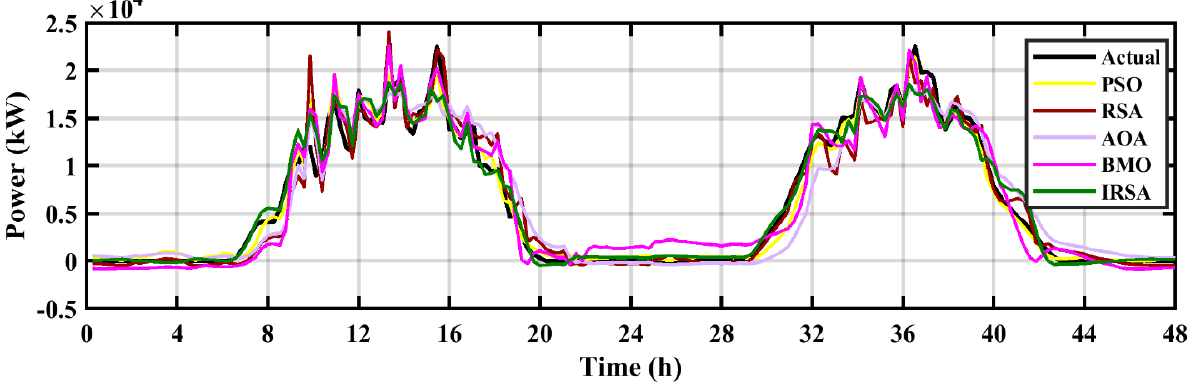
Figure 11. Solar Power Prediction